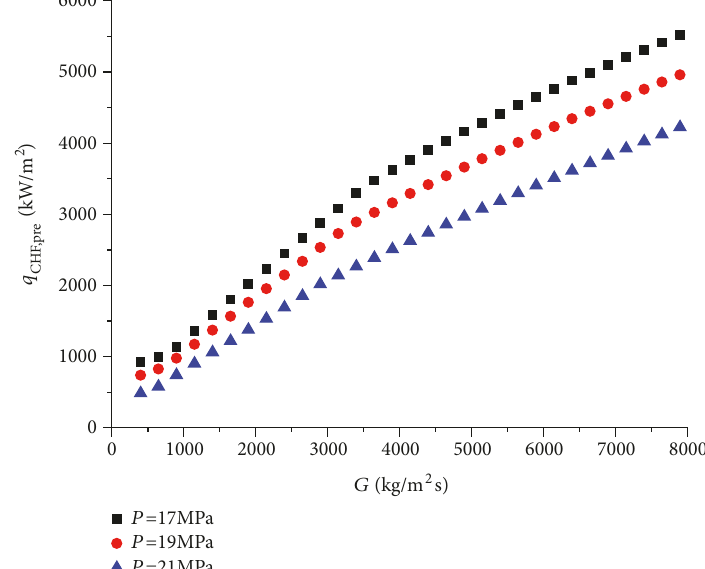
Figure 11: CHF as a function of mass velocity ( Δℎ in =500kJ/kg).